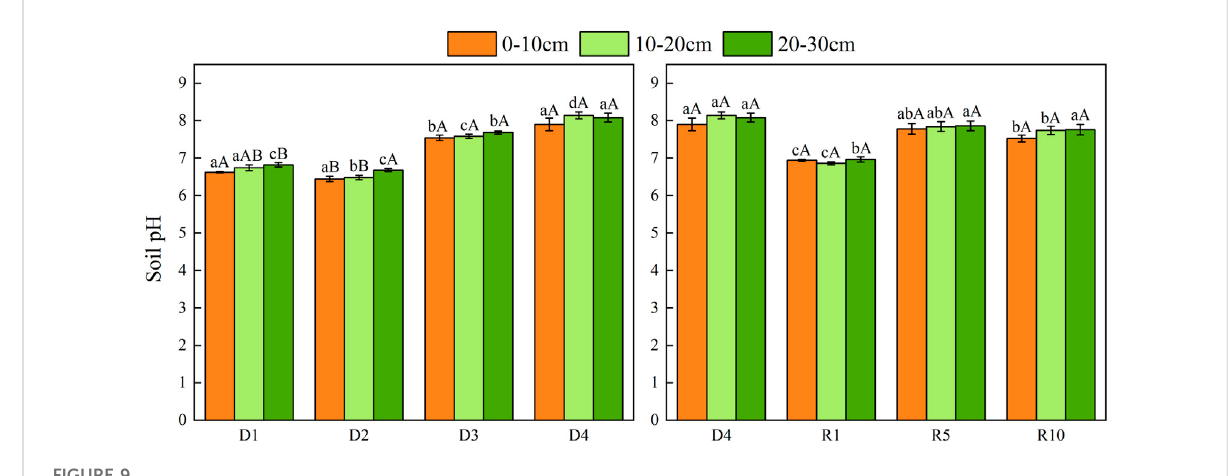
FIGURE 9 Changes in soil pH under different soil layers at different degradation stages and recovery years.